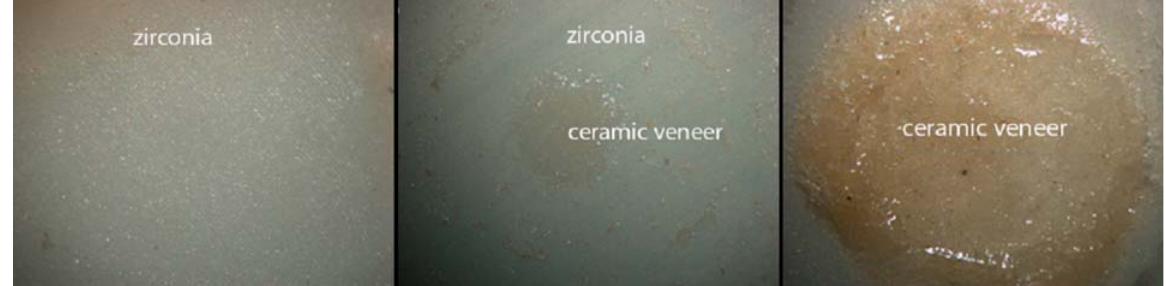
Figure 6- Failure types: adhesive failure (zirconia), mixed failure (zirconia and ceramic veneer), and cohesive failure (ceramic veneer)